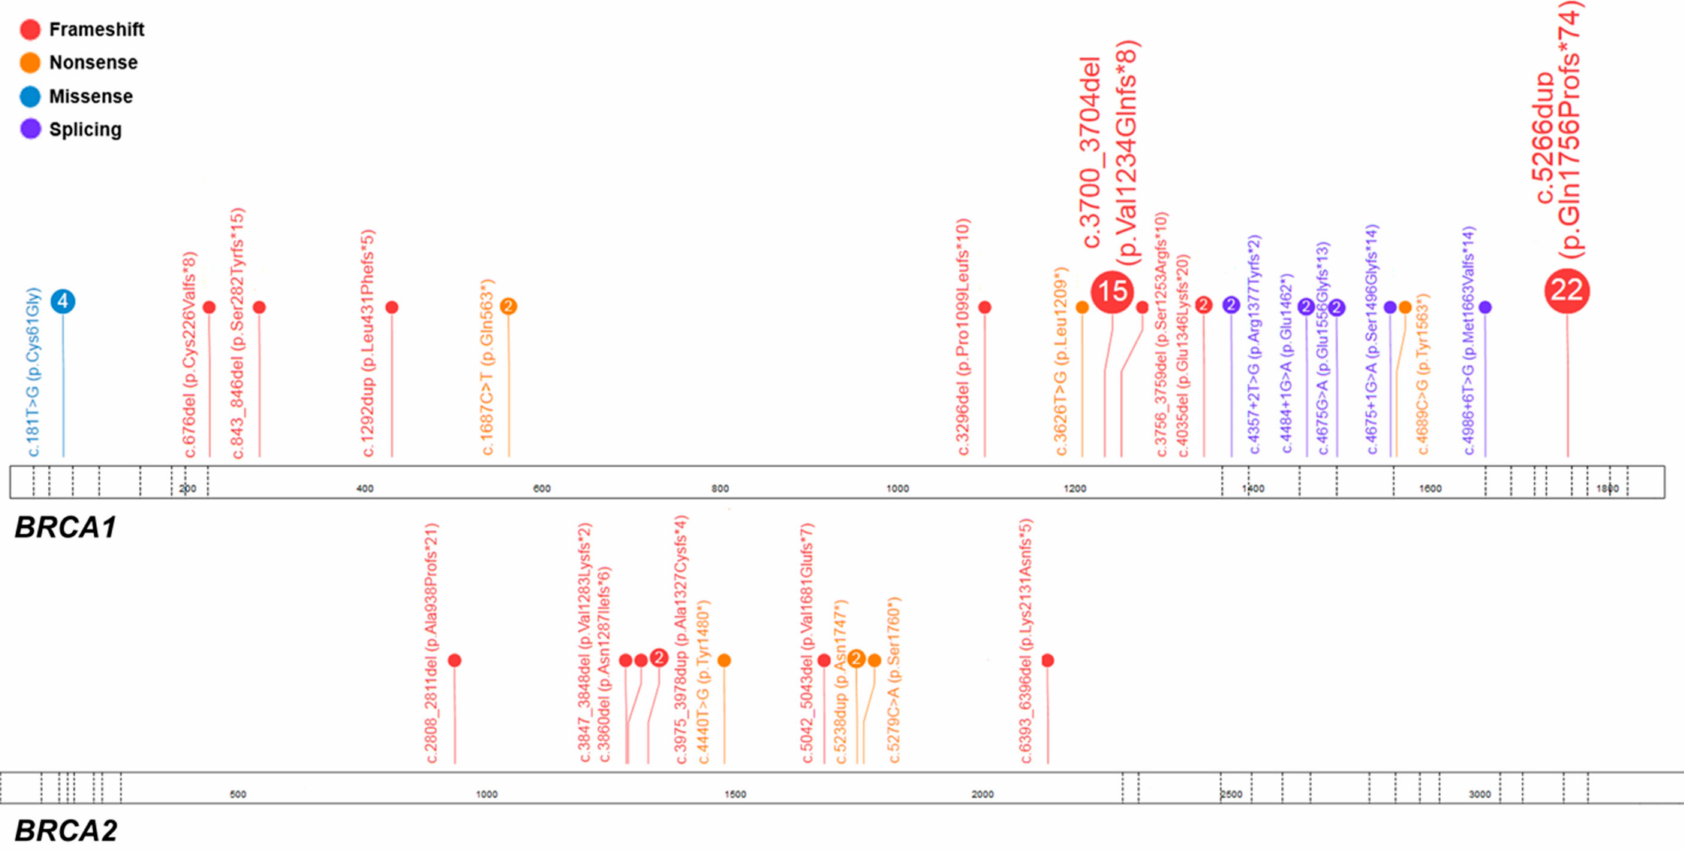
Figure 1. Spectrum of the BRCA1/2 pathogenic variants identified in the studied cohort of 333 unselected ovarian cancer individuals. Each number in circle corresponds with the total number of individuals heterozygous for a specific variant. The figure was prepared using the ProteinPaint application ( © Copyright 2015 St. Jude Children’s Research Hospital; 262 Danny Thomas Place, Memphis, TN 38105, USA)